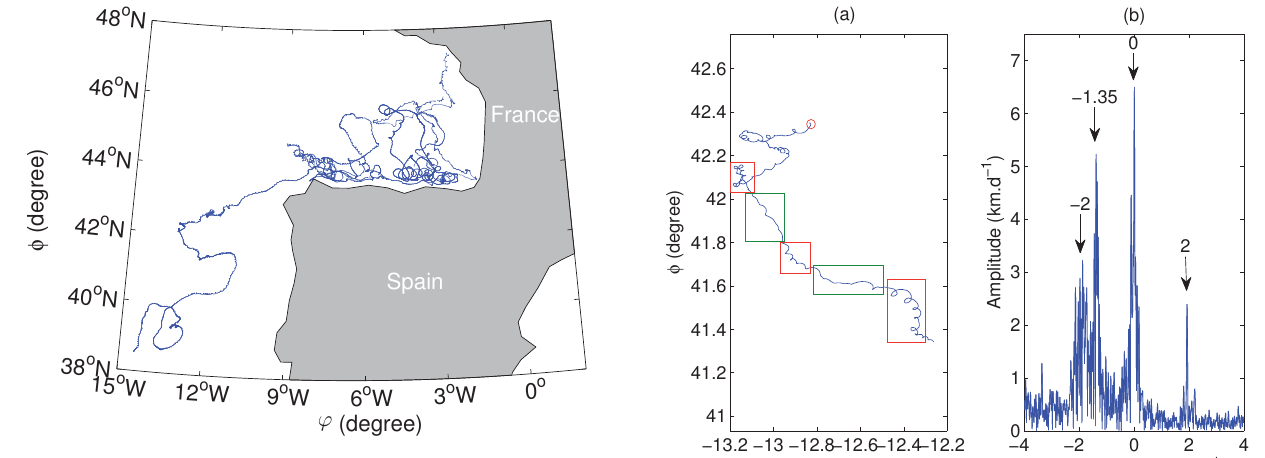
Fig. 2. Map of the Atlantic Ocean showing the oceanic buoy trajec- tories deployed during the Congas project. The positions are sam- pled every 1h and plotted following a Lambert projection. Fig. 3. (a) 1 month sample of the trajectory of buoy B245 (25 May to 25 June 2007). The trajectory is plotted in latitude-longitude co- ordinates. Its beginning is marked by the red circle. The red and green boxes outline periods with strong and low cycloidal loop ac- tivity, respectively. (b) Fourier spectrum of the buoy velocity. The velocity is computed following Eq. (3) with 1t =